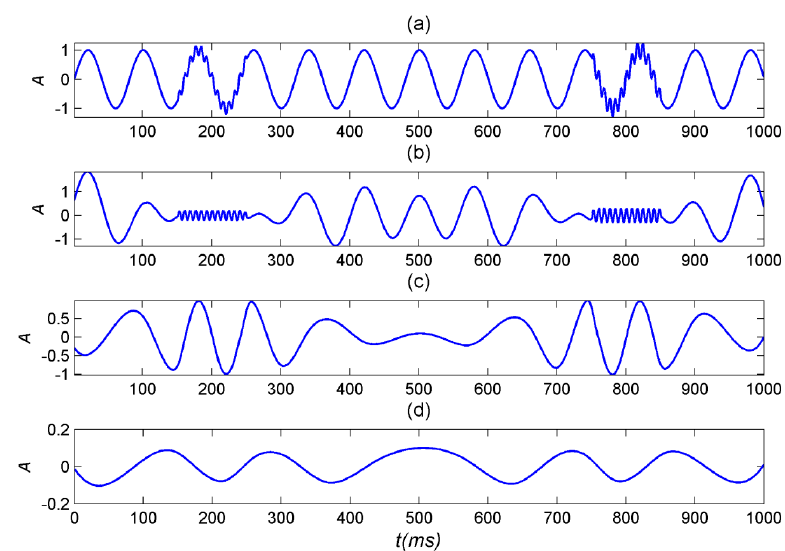
Figure 1. Analysis results of a simple artificial signal using empirical mode decomposition (EMD): ( a ) the signal; ( b ) IMF1 of the signal; ( c ) IMF2 of the signal; and ( d ) IMF3 of the signal.